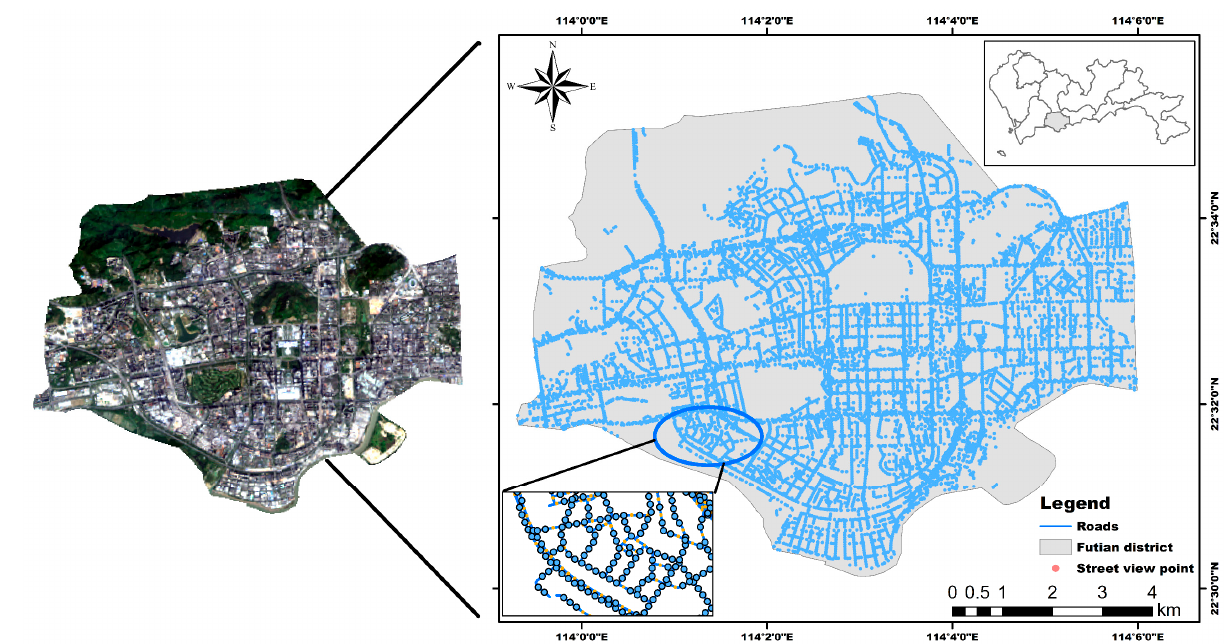
Figure 2. Visualization of the study area and basic data.